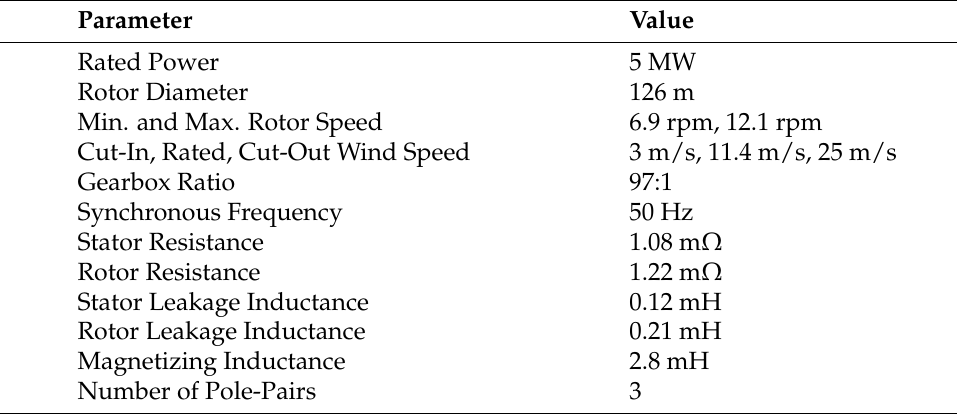
Table 1. Parameters of five MW DFIG wind